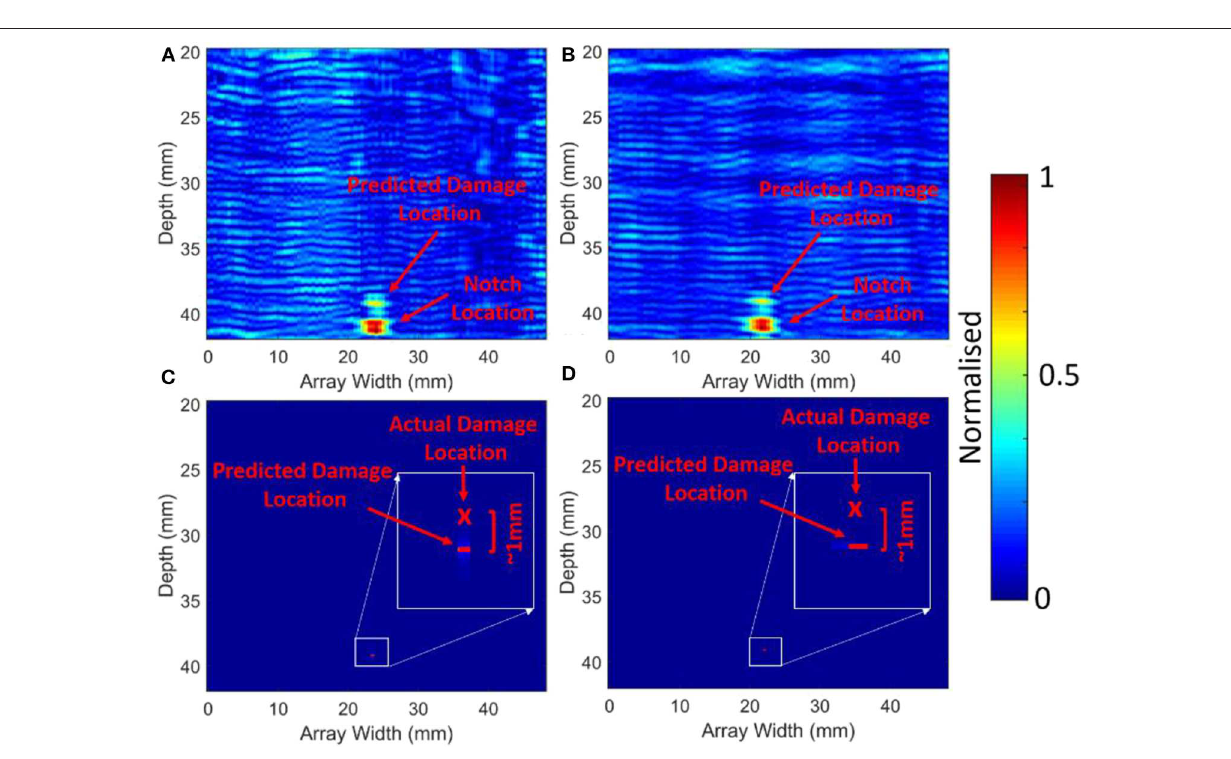
Frontiers in Built Environment |